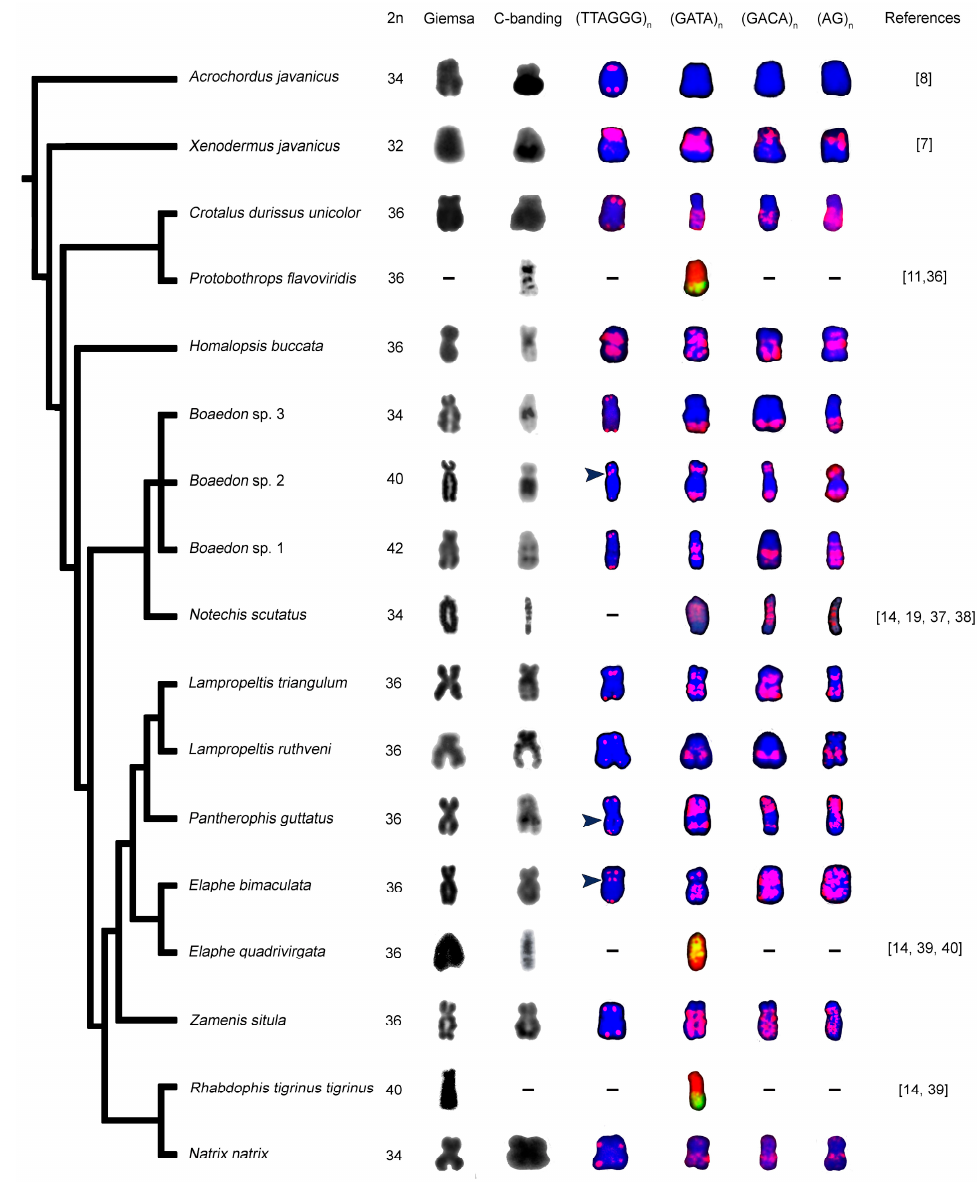
Figure 1. Comparative phylogenetic reconstruction of the heterochromatic content of the W chromosomes in Caenophidia. The phylogenetic tree of studied snakes was completed according to phylogenies by [2]. We compared the morphology of W chromosomes (Giemsa stain), the pattern of heterochromatin accumulation (C-banding) and the topology of four microsatellite repeats: (TTAGGG) n , (GATA) n , (GACA) n and (AG) n (FISH). The chromosomes from C-banding and FISH experiments were counterstained by 4 ′ ,6-diamidino-2-phenylindole (DAPI). Photos of C-banding were inverted. In the case of FISH experiments, the chromosomes with DAPI were stained blue, and the fluorescence signal of probes was pseudo-colorized in red. Dashes represent missing data. Interstitial telomeric repeats (ITRs) on W chromosomes are indicated by arrows when they are not easily visible. For data collected from the bibliography, see the references inside the